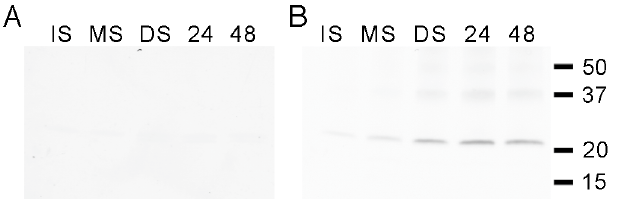
Figure 6. Seed membrane fractions immunoprecipitated with phosphotyrosine antisera, then fractionated by SDS-PAGE and co-labeled with either ( A ) aTIPnt13C antisera against PvTIP3;1 or ( B ) bTIPnt15C antisera against PvTIP3;2. Blot lanes: IS, immature seed; MS, mature seed; DS, dry seed; 24, seed imbibed for 24 h; 48, seed imbibed for 48 h. Position of molecular weight markers (kDa) indicated on right.